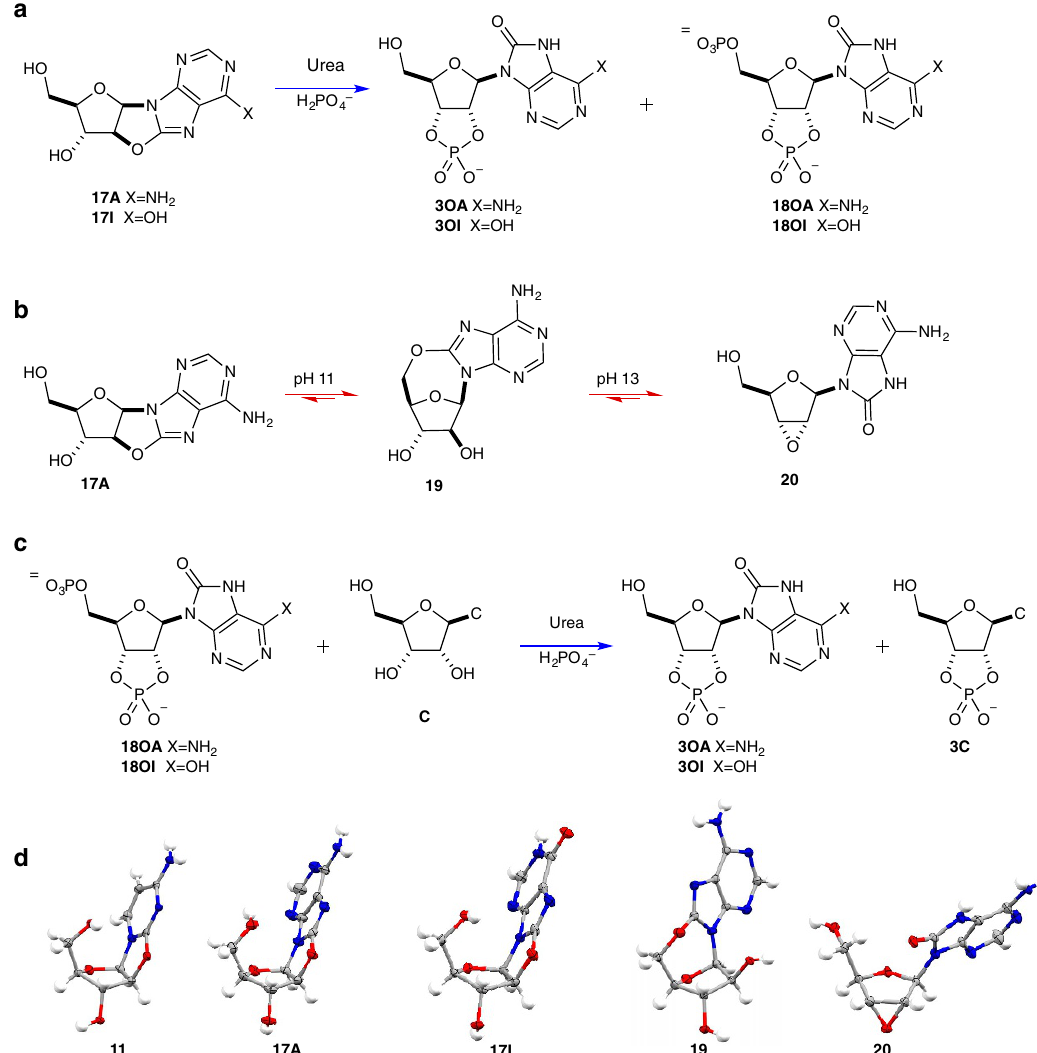
Figure 6 | Urea-mediated phosphorylation of 8,2 0 - O -cyclo-purines. ( a ) Urea-mediated phosphorylation of 8,2 0 - O -cyclo-adenine ( 17A ) and 8,2 0 - O -cyclo- inosine ( 17I ) to yield 8-oxo-adenosine-2 0 ,3 0 -cyclic phosphate ( 3OA ) and 8-oxo-inosine-2 0 ,3 0 -cyclic phosphate ( 3OI ). ( b ) Equilibration of 8,2 0 - O -cyclo- adenine ( 17A ) with 8,5 0 -anhydro-8-oxyadenine ( 19 ) and 2 0 ,3 0 -anhydro-8-oxo-adenosine ( 20 ) upon incubation in alkaline solution. ( c ) Urea-mediated conversion of bisphosphate 18 to monophosphate 3 , driven by the irreversible synthesis of 2 0 ,3 0 -cyclic phosphates. ( d ) Single crystal X-ray structures of anhydrocytidine ( 11 ), 8,2 0 - O -cyclo-adenine ( 17A ), 8,2 0 - O -cyclo-inosine ( 17I ), 8,5 0 -anhydro-8-oxyadenine ( 19 ) and 2 0 ,3 0 -anhydro-8-oxo-adenosine ( 20 ). Structure 11 was reported in ref. 4 and is shown for comparison to structures 17A and 17I